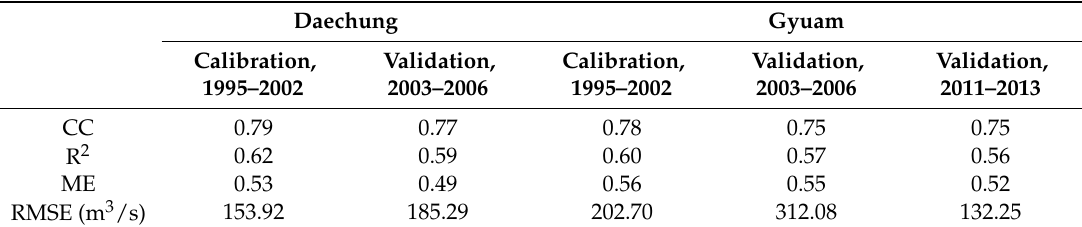
Table 4. Calibration and validation results of the model for daily discharge data.